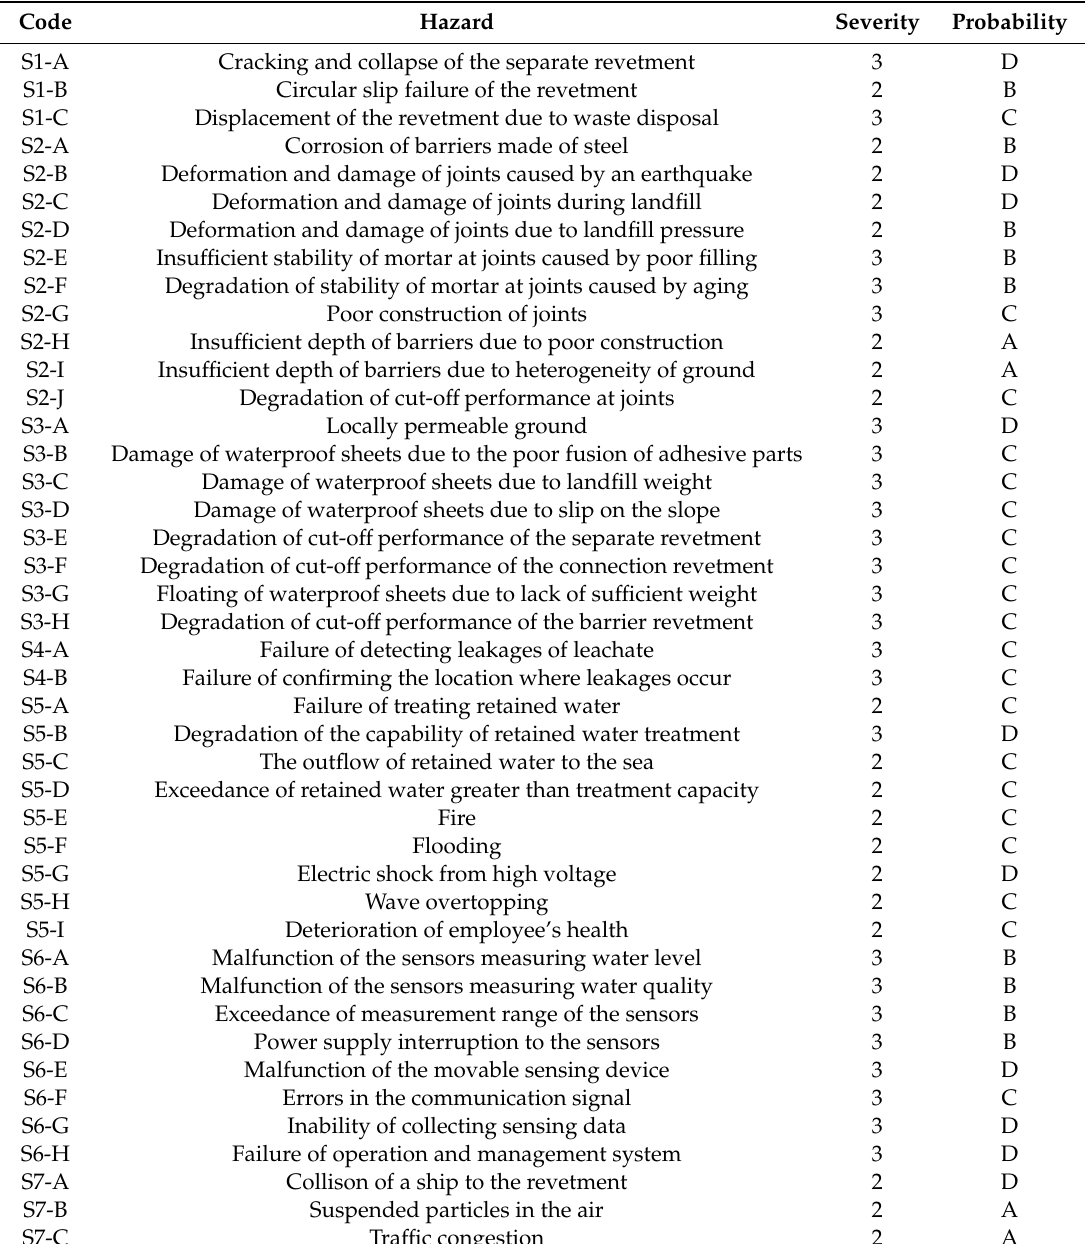
Table 4. The list of severities and probabilities of all 43 identified